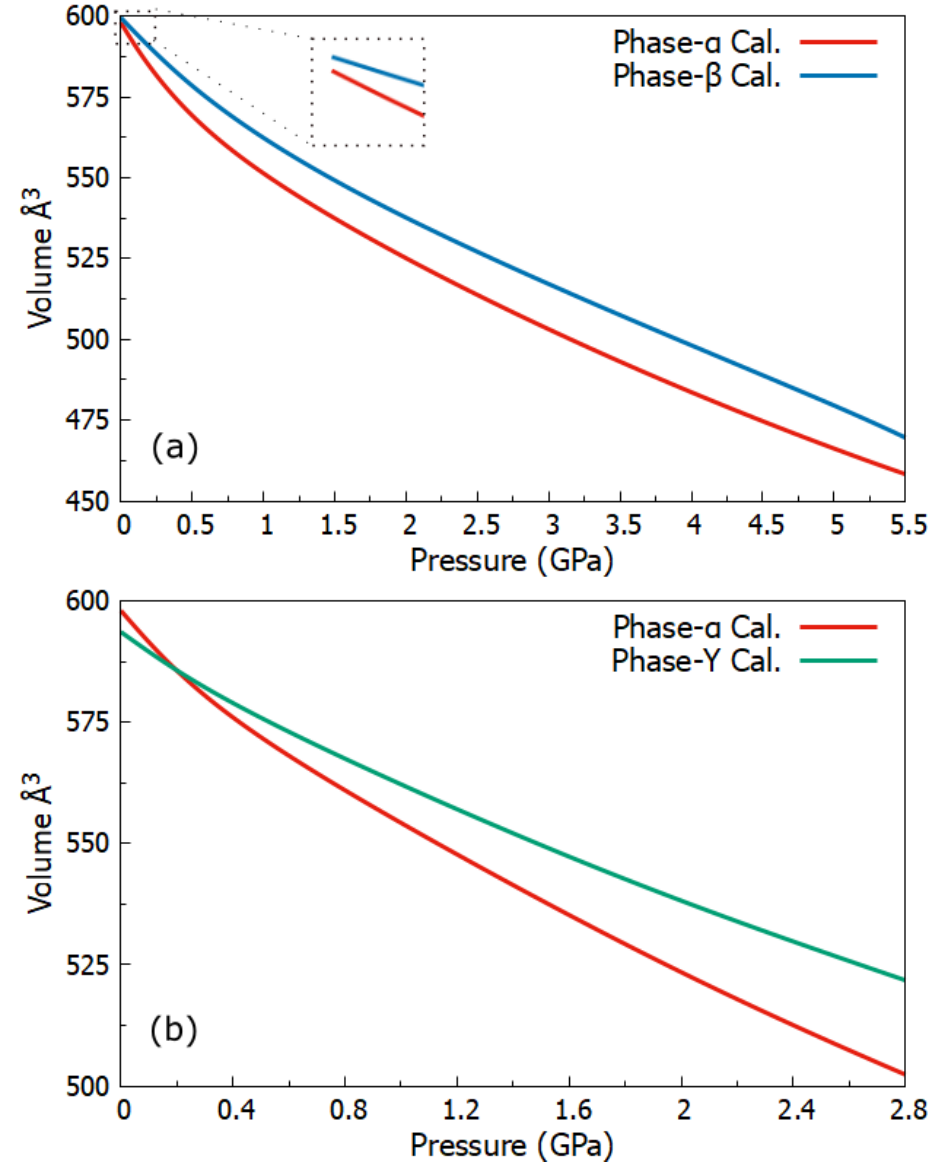
Figure 2. The ab initio calculated change in volume for three phases of p-Tol 2 S 2 with respect to pressure, all curves were fitted with the Bezier function. ( a ) Shows volume change in phases α and β by increasing pressure from atmospheric to 5.5 GPa. ( b ) Shows volume change in phases α and γ by increasing pressure from atmospheric to 2.8 GPa.